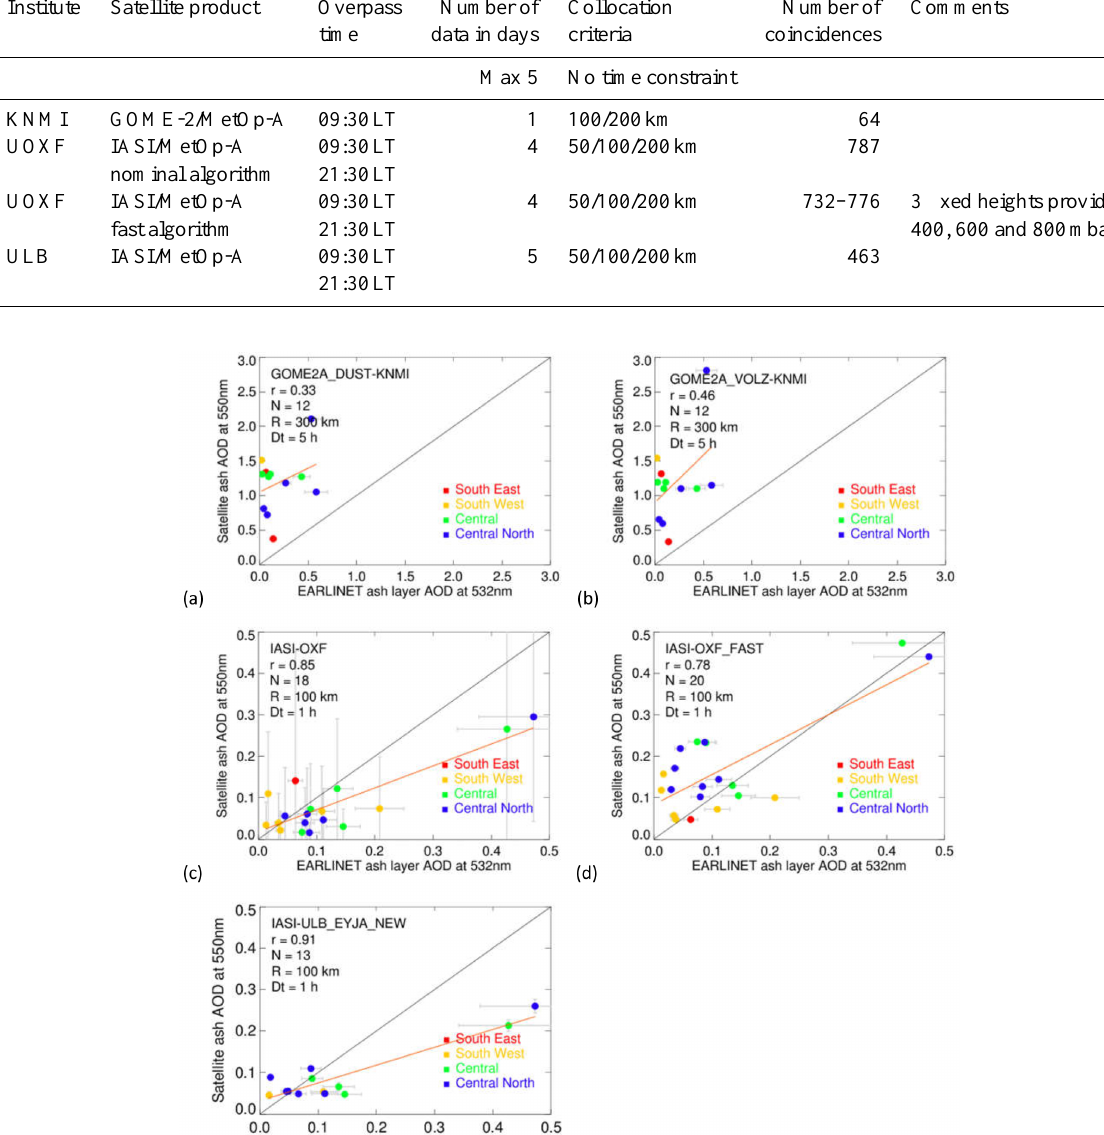
Figure 2. Scatter plots between satellite ash optical depth at 550nm and EARLINET ash layer optical depth at 532nm for GOME-2A (a, b) , IASI-UOXF (c, d) and IASI-ULB (e) products. Different colours correspond to different European domains. See Table 1 for more